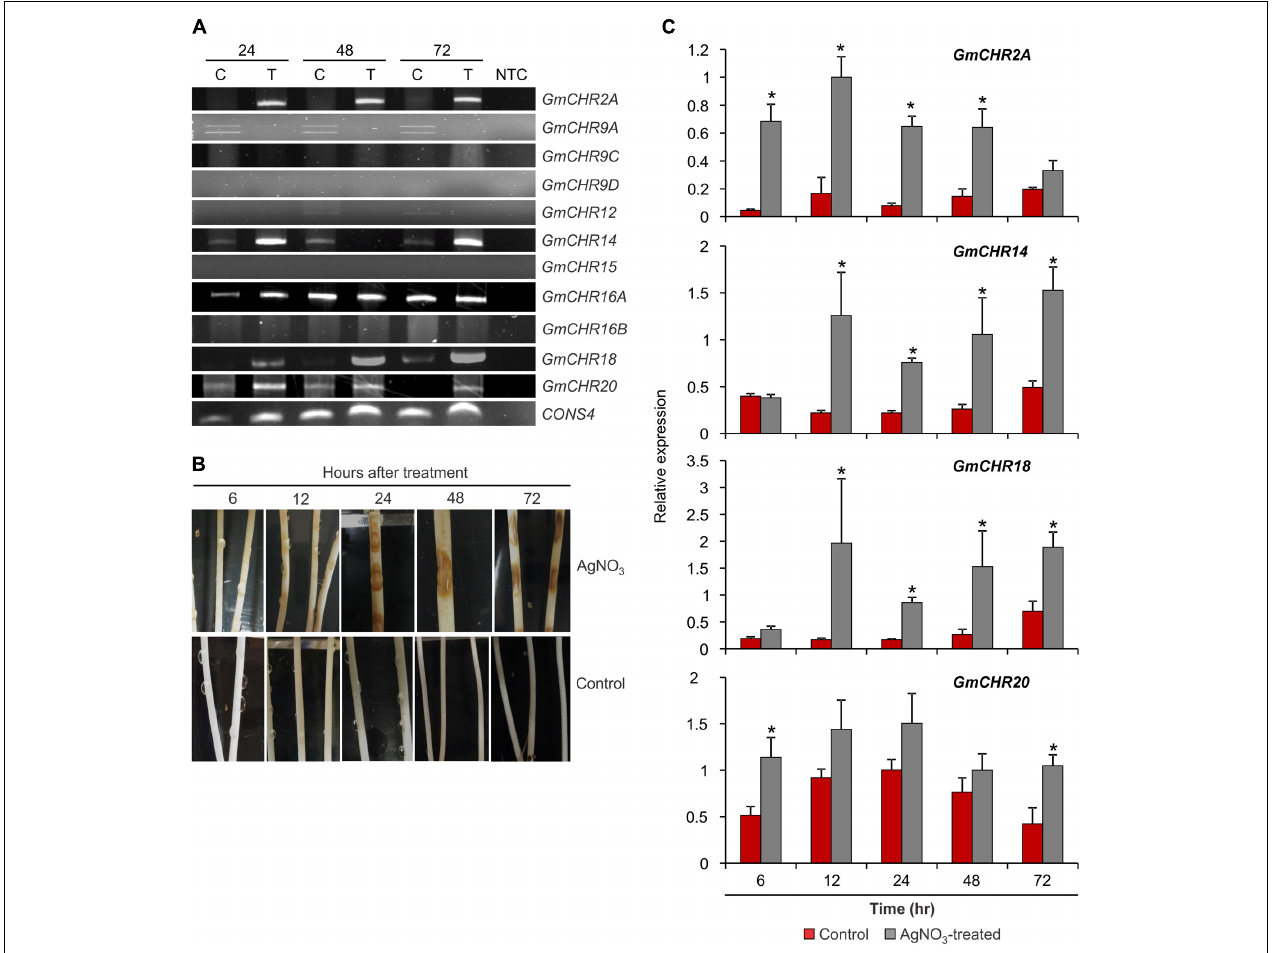
FIGURE 5 | Expression of root-specific GmCHR s in response to stress. (A) Expression of GmCHRs in response to P. sojae infection. Total RNA (1 µ g) from P. sojae -infected stems of soybean cv. L76-1988 (T) and control (C) for 24, 48 or 72 hr was used to synthesize cDNA. Expression analysis was conducted by RT-PCR with GmCHR gene-specific primers. NTC indicates no template control. CONS4 was used as a loading control. (B) Effects of AgNO 3 on etiolated soybean cv. Harosoy63 hypocotyls. Soybean seeds were grown in dark at 24 ◦ C for 6 days in water-soaked vermiculite. The seedlings were then placed onto a tray and inoculated with either water (control) or 1 mM AgNO 3 (treated). Photographs were taken at the time points as indicated. (C) Detail expression analysis of 4 root-specific GmCHRs . Total RNA (1 µ g) of soybean cv. Harosoy63 was used to synthesized cDNA from untreated and AgNO 3 -treated hypocotyls. Expression analysis was conducted by qPCR with GmCHR gene-specific primers. Error bars indicates standard error of the mean (SEM) of two biological and three technical replicates per biological replicates. CONS4 was used as a reference gene. The asterisks ( ∗ ) denotes significant expression as determined by Student’s t -test ( p < 0.05).